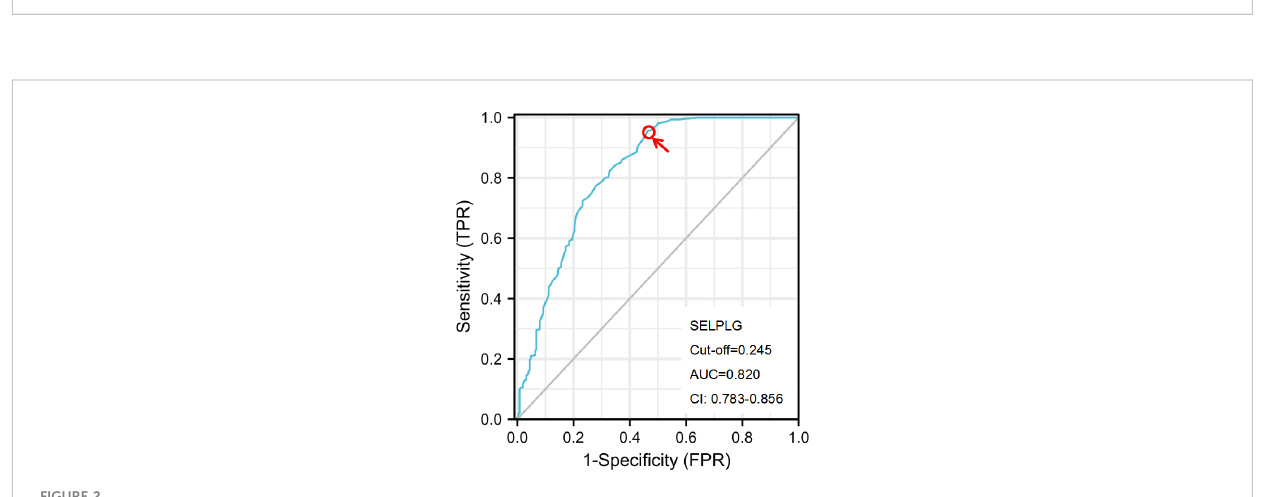
FIGURE 2 The ROC curve analysis of the PSGL-1 for identifying CIN2+ disease. The optimal PSGL-1 expression used to predict CIN2+ was calculated according to the ROC curve. CIN, cervical intraepithelial neoplasia; NILM, negative for intraepithelial lesion or malignancy; CC, cervical cancer; AUC, the area under the ROC curve; ROC, receiver operator characteristic.